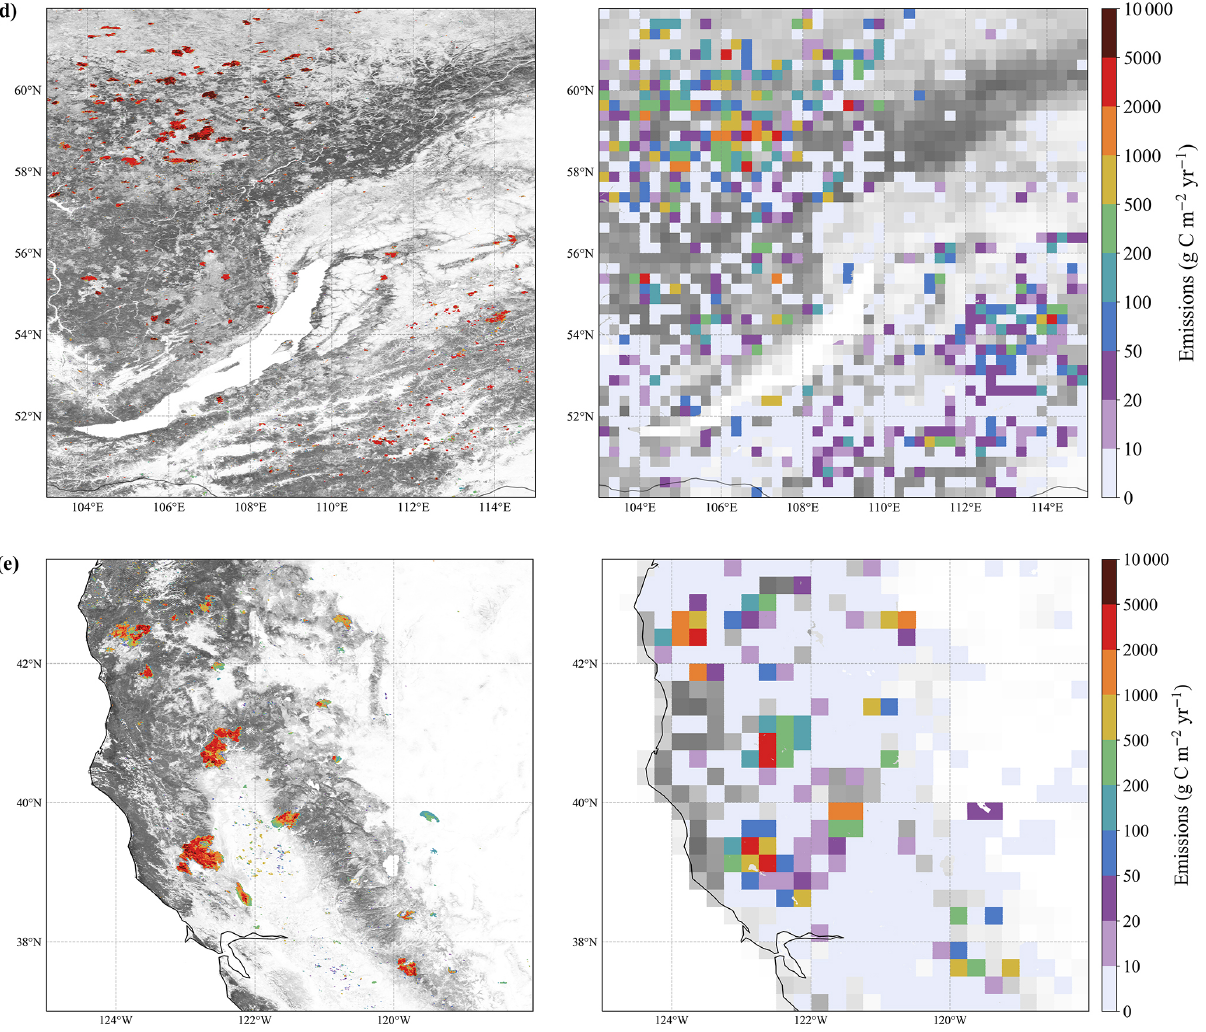
Figure 9. Regional maps of annual emissions from the 500m model (left column) and GFED4s (right column; with a model resolution of 0.25 ◦ ). (a) Deforestation in the south-eastern part of the Brazilian Amazon and the transition to savanna fires in the Brazilian Cerrado for 2004. (b) Deforestation on Borneo for 2006, including fires in drained peatlands (primarily on the southern coast). (c) Savanna fires and deforestation in the south-eastern part of the Congo Basin for 2016. (d) Boreal wildfires north and east of Lake Baikal in Siberia for 2017. (e) Temperate wildfires on the west coast of the United States for 2018. Greyscales show fractional tree